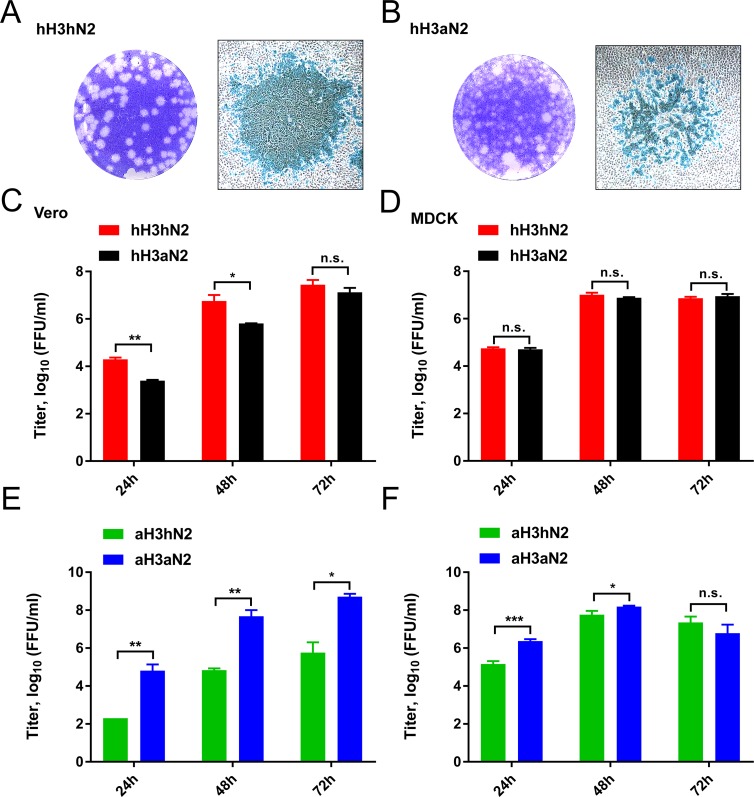
Plaque morphology and replication kinetics of recombinant viruses.Plaque assays were performed for hH3hN2 (A) and hH3aN2 (B) viruses using Vero cells followed by crystal violet dye staining (left panels) or by immunostaining of infected cells (right panels). Vero (C and E) or MDCK (D and F) cells were infected with hH3hN2 or hH3aN2 (C and D), or with aH3hN2 or aH3aN2 (E and F). Virus in the cell culture supernatants at the indicated times post infection was titrated, and the titres were expressed as log10 (FFU/ml). Standard deviations are indicated. Significant differences were analysed using an unpaired two-tailed Student t test (*, P<0.05; **, P<0.01; ***, P<0.001; n.s., not significant).